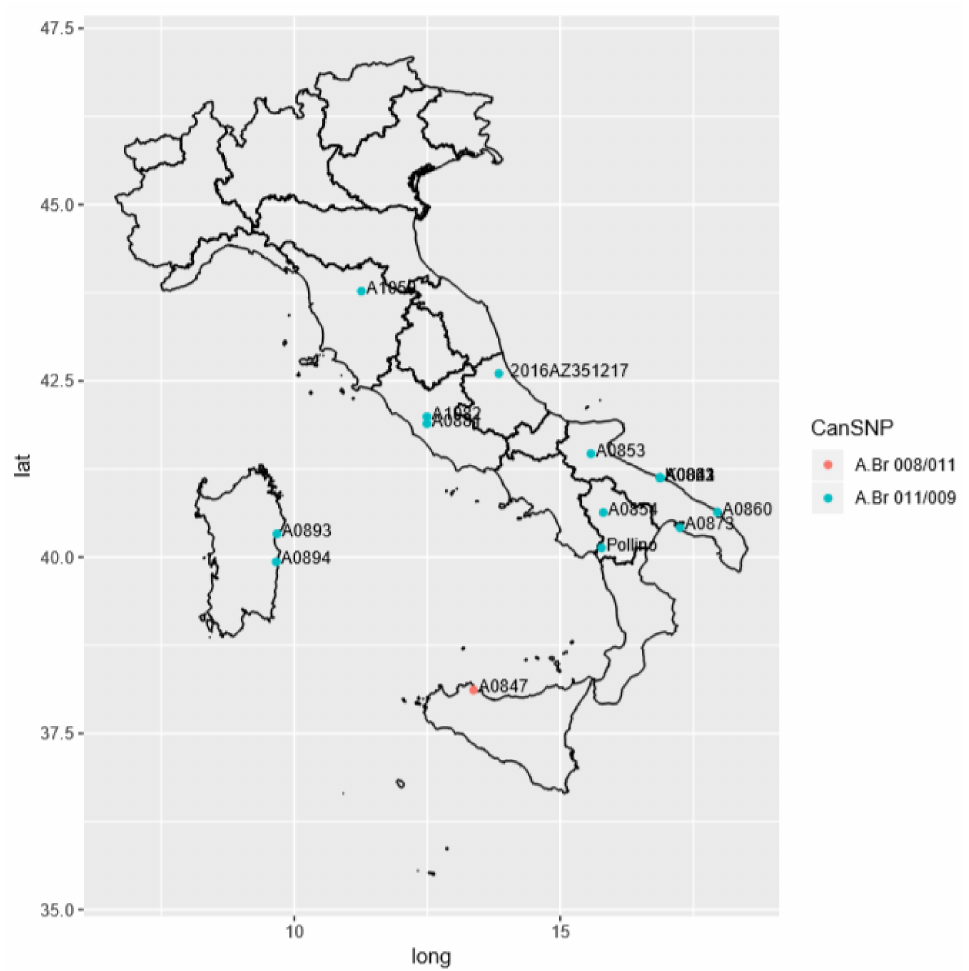
Figure 3. Geographical distribution of Italian strain representing one of the outputs of in-house pipeline used in this study. The legend reports the canSNP sub-group A.Br.008 / 011 and A.Br.011 / 009 as a red circle and blue circles, respectively. The study strain is represented as